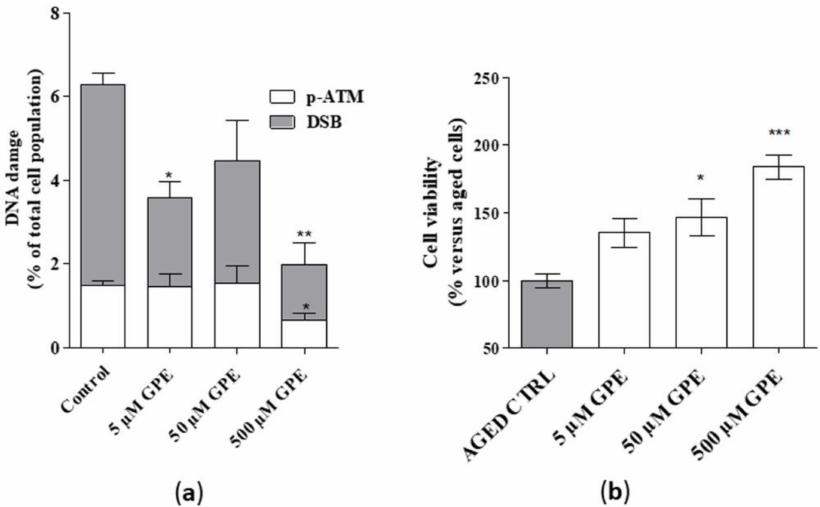
Figure 4. ( a ) Human hippocampal neurons were incubated with saline bu ff er (control cells) or GPE (5, 50, and 500 µ M) for 21 days in vitro (DIV). Following incubation, cells were collected and lysed. DNA damage (DSB and phospho-ATM) was quantified by cytofluorimetric analysis (Muse TM ). Data are the mean ± SEM of two di ff erent experiments, each performed in duplicate, and are reported as percentage of total cell population. ( b ) Human hippocampal neurons were treated as in A. Following incubation, cellular viability was measured by MTS assay. Data are the mean ± SEM of two di ff erent experiments, each performed in duplicate, and reported as percentage of untreated aged cells (control). Statistical analysis was performed by one-way analysis of variance (ANOVA) with Bonferroni’s corrected t-tests for post-hoc pair-wise comparisons: * p < 0.05, ** p < 0.01, *** p < 0.001 versus control (aged